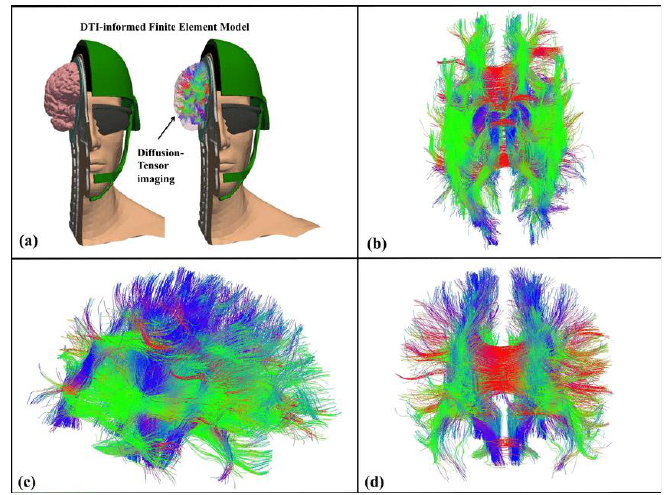
Figure 5. DTI can be used to construct a transversely isotropic model by overlaying axonal fiber tractography on a finite element mesh: ( a ) DTI-informed Finite Element Model; tractography shows complex fibers from ( b ) the dorsal view, ( c ) the right lateral side view, and ( d ) the posterior view. Cartography of the tracts’ position, direction by color: red for right-left, blue for foot-head, green for anterior-posterior [289].